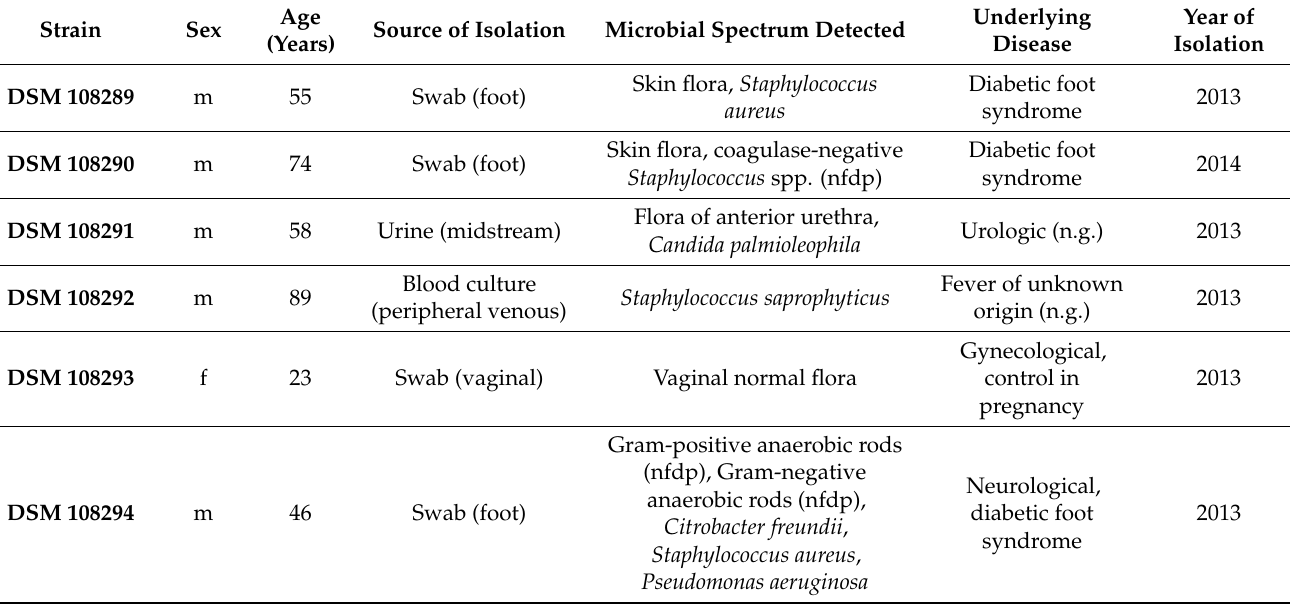
Table 1. Clinical data on the A. radioresistens strains from the strains collected in Dresden. Underlying Year of Strain Sex Source of Isolation Microbial Spectrum Detected Disease Isolation Skin flora, Staphylococcus Diabetic